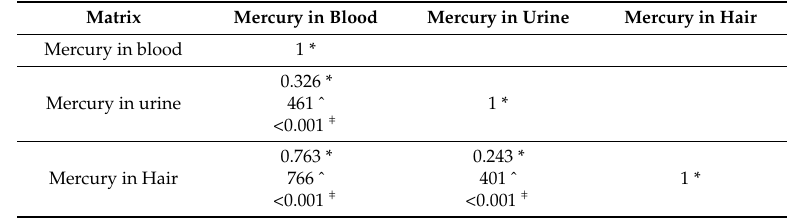
Table 1. The Spearman correlation for the natural logarithm of mercury levels in blood, urine, and